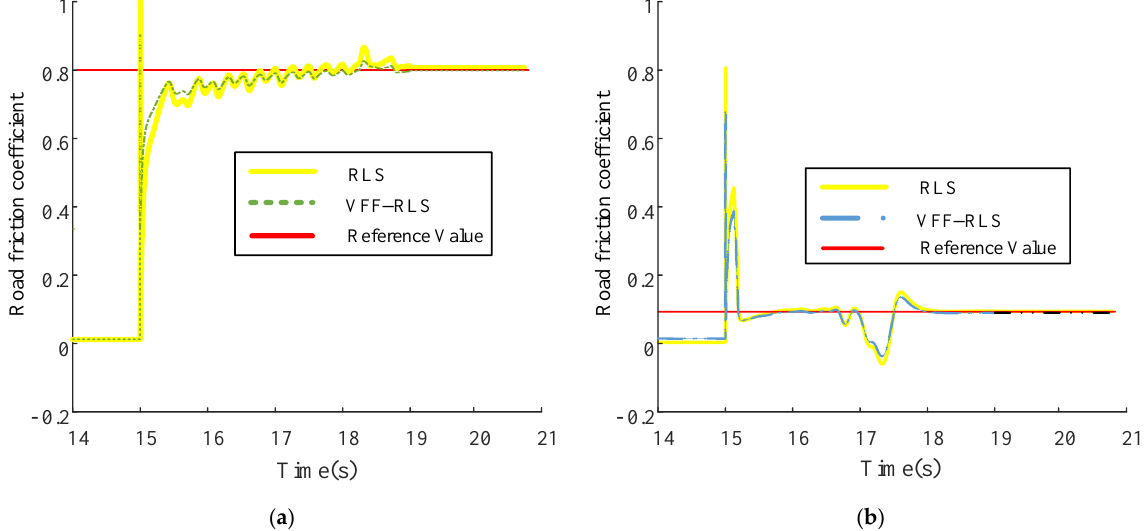
Figure 9. Estimation of road friction coefficient. ( a ) When road friction coefficient is 0.8 ( b ) When road friction coefficient is 0.1.